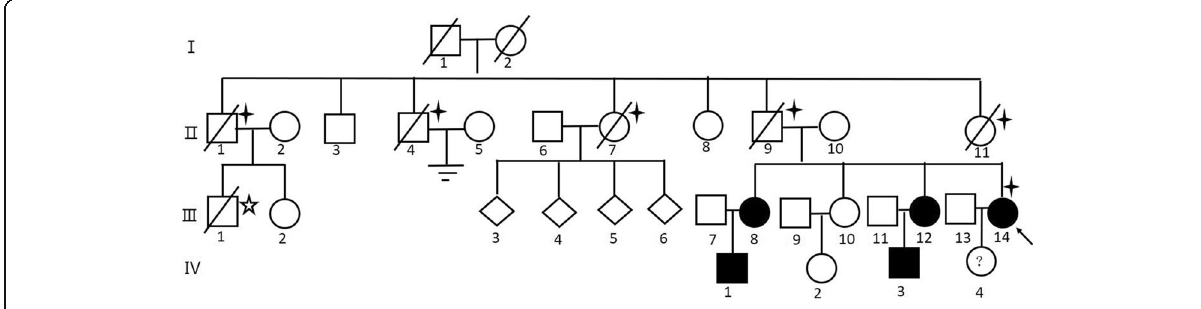
Fig. 1 Pedigre of family 1.